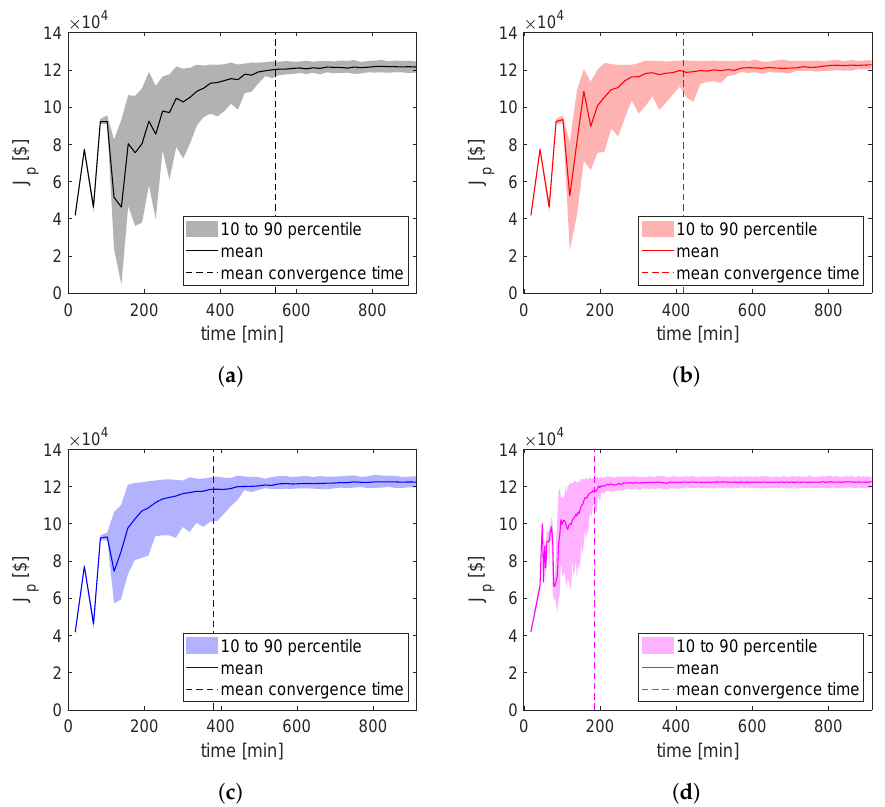
Figure 11. Lithiation reaction case study: mean and standard deviation of plant profit function and mean time of convergence for 100 simulations. Convergence is assumed when profit for inputs from five consecutive iterations is greater than 1.175 ( b ) MAWQA with GMA with APCI. ( c ) MAWQA with GMA with APENI. ( d ) MAWQA with GMA with proactive perturbation.